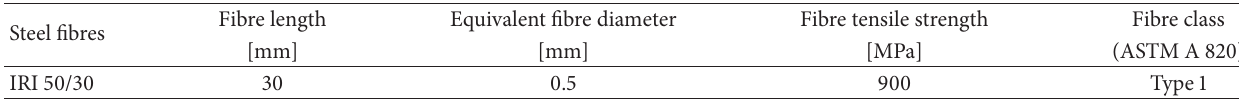
Table 2: Properties of the used steel fibres.